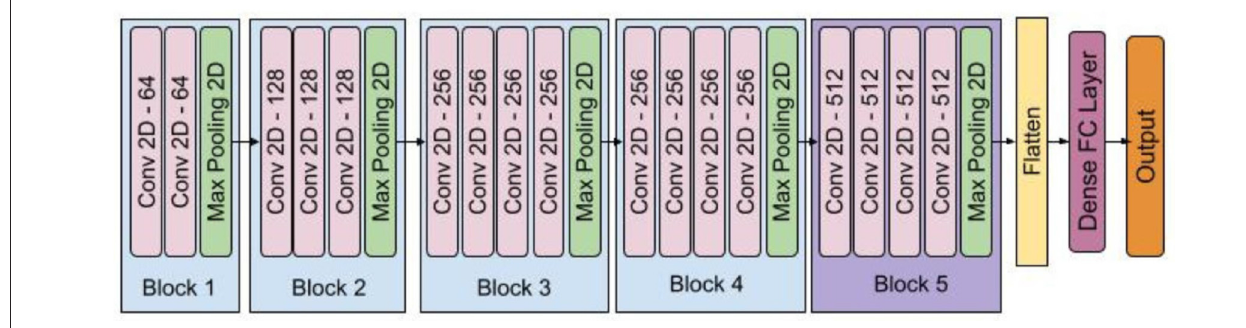
FIGURE 5 | Facial macro-expression model.